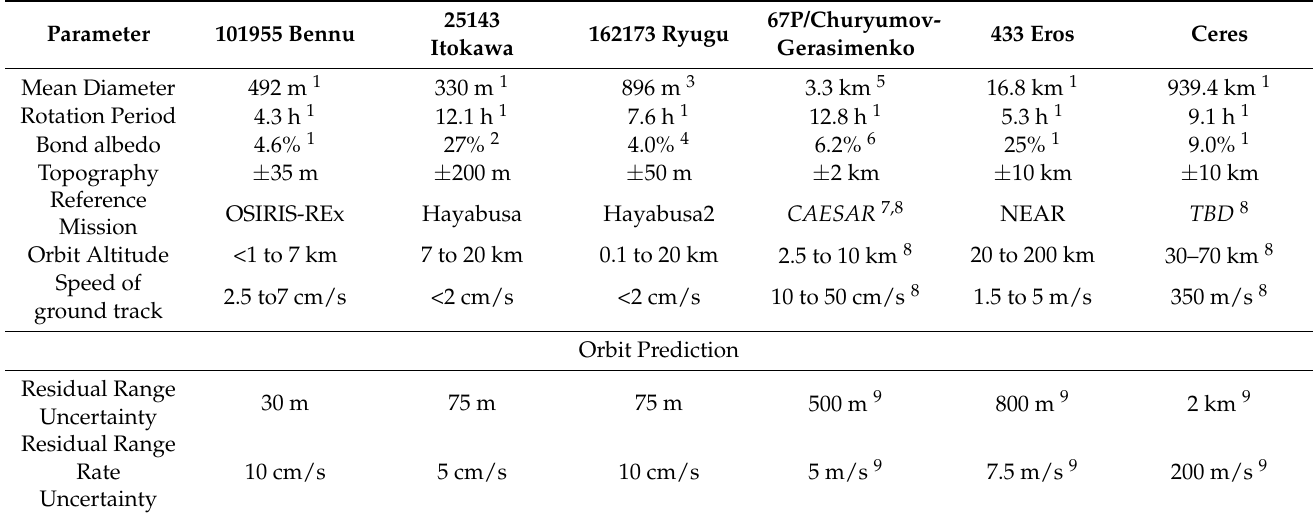
Table 1. List of orbit dynamics of past asteroids and comet missions. References are indicated for measured values. The other values are derived from shape and trajectory